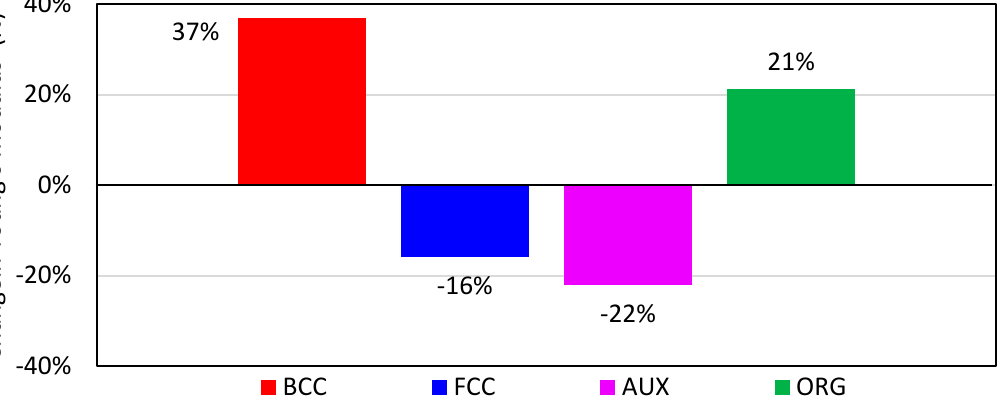
Figure 19. Change in bulk Young’s modulus from UC to entire lattice simulation for each design.